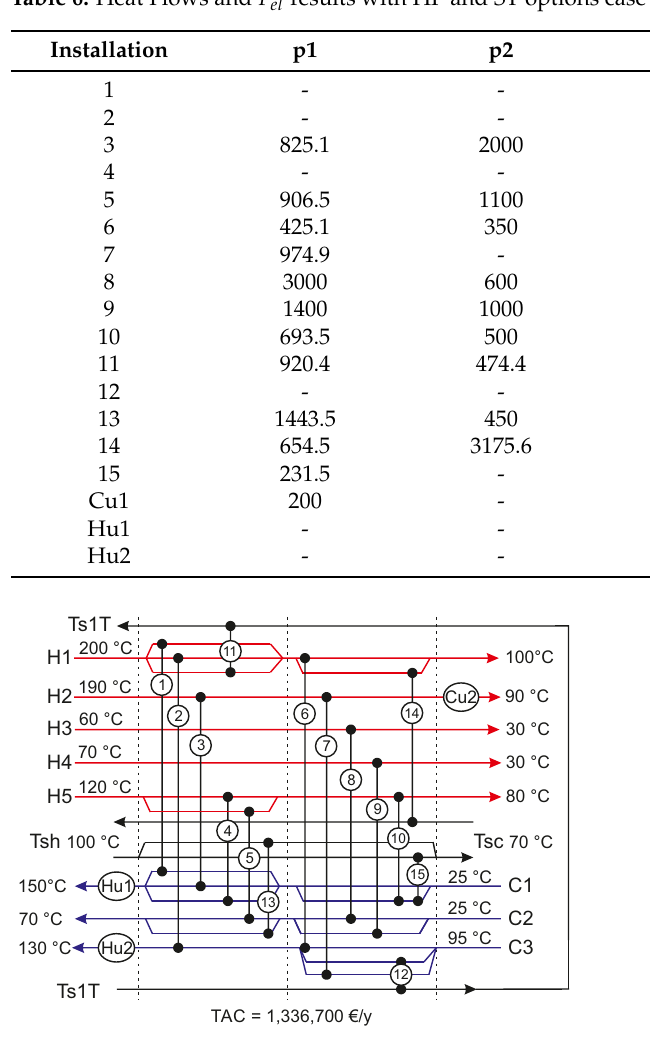
Figure 3. HEN obtained with HP and ST options case